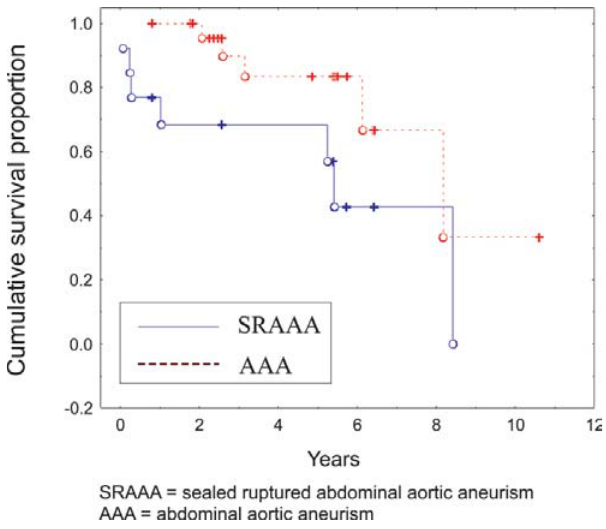
Figure 2 - Kaplan-Meyer curves for 13 patients with sealed ruptured AAA (SRAAA) and 26 controls